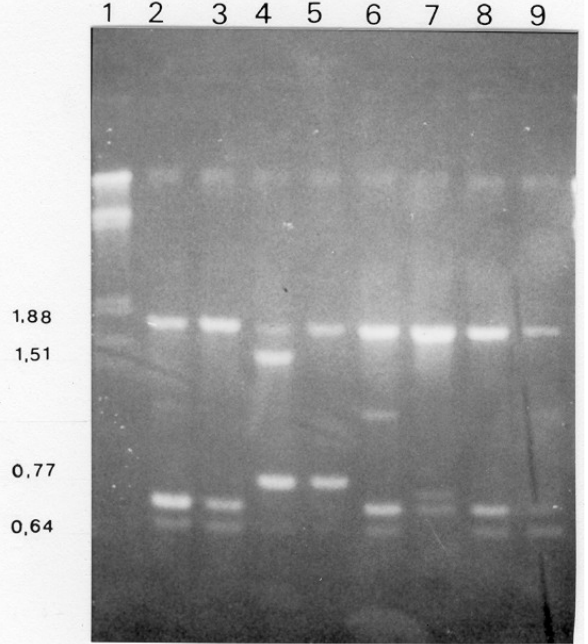
Figure 2 - Amplification products generated from Drechslera teres iso- lates with primer B10. Lane (1)Lambda DNA digested with Eco RI and Hind III used as molecular weight marker. Lane: (2) isolates Sanad599; (3) Pirat599; (4) Saog599; (5)Vacar599; (6) Palme599; (7) Caraz599; (8) Encru599 (9); Ipira599. Fragment sizes in base pairs are indicated on the right.